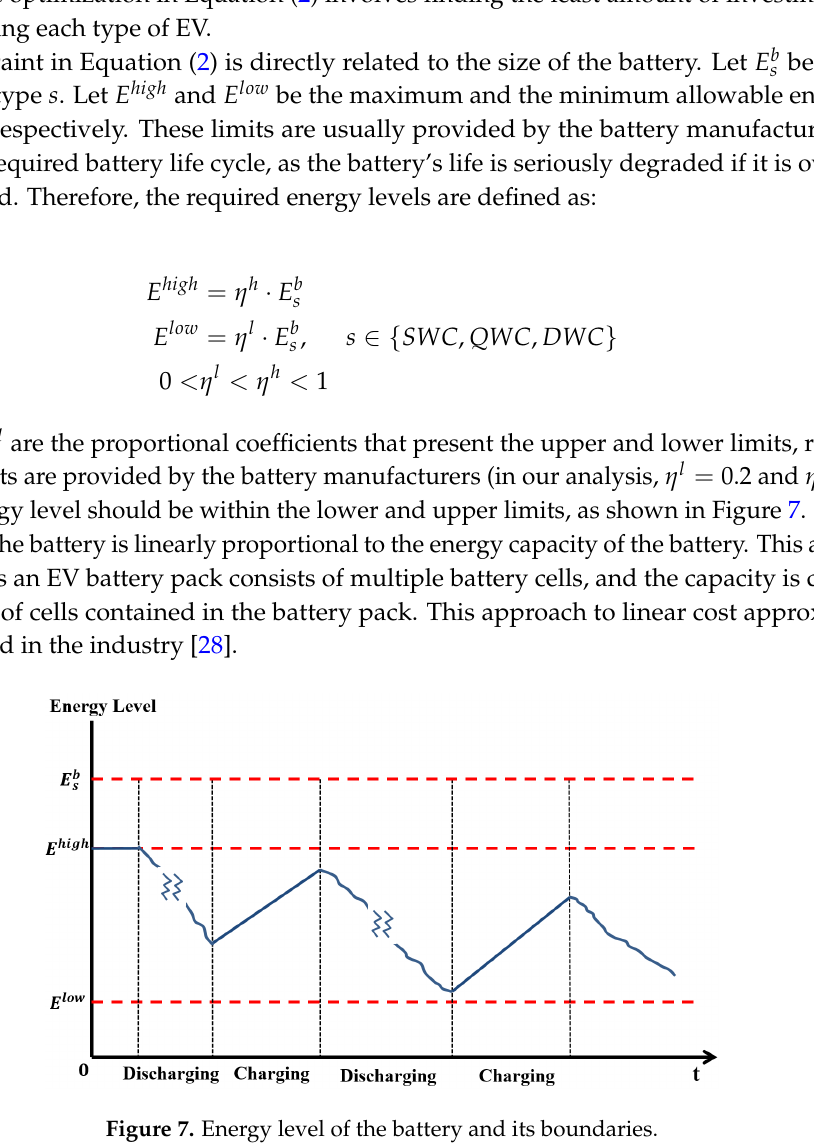
Figure 7. Energy level of the battery and its